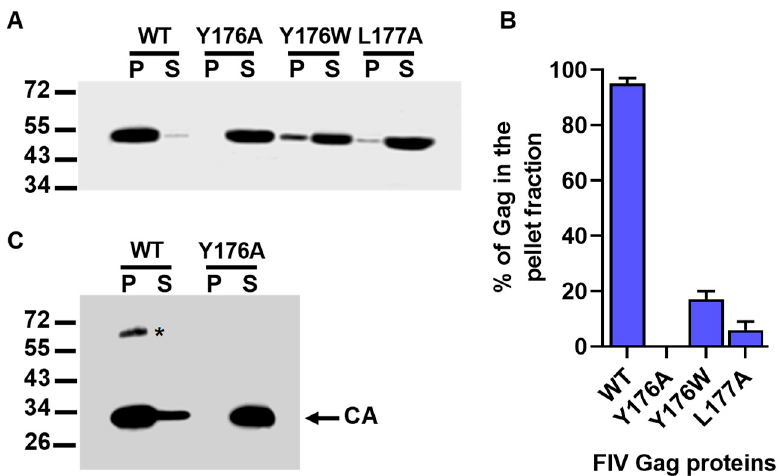
Figure 3. In vitro assembly reactions for the recombinant FIV Gag polyproteins containing the Y176A, Y176W, and L177A amino acid substitutions in the CA domain. In vitro oligomerization ability of the FIV CA Y176A mutant polypeptide. ( A ) Sedimentation analysis of the assembly reactions of purified wild-type (WT) and mutant His-FIV Gag proteins. After incubation of the assembly mixtures, the pellet (P) and supernatant (S) fractions were separated by centrifugation. The P and S fractions were then analyzed for the presence of Gag protein by Western blotting using the anti-FIV CA MAb. Results shown are representative of three independent experiments. ( B ) The percentage of the total amount of each Gag polyprotein that partitions into the P fraction was quantitated. Values represent the mean of three independent experiments ± the standard deviation. ( C ) Sedimentation analysis of the in vitro assembly reactions for recombinant wild-type (WT) and Y176A FIV CA proteins. The purified His-FIV CA polypeptides were incubated under the conditions described in Materials and Methods, and the partitioning of the His-FIV CA proteins into the pellet (P) and supernatant (S) fractions was determined by Western blotting using the MAb specific for the FIV CA. The asterisk (*) indicates SDS-resistant CA dimers present in the P fraction of the wild-type CA protein.